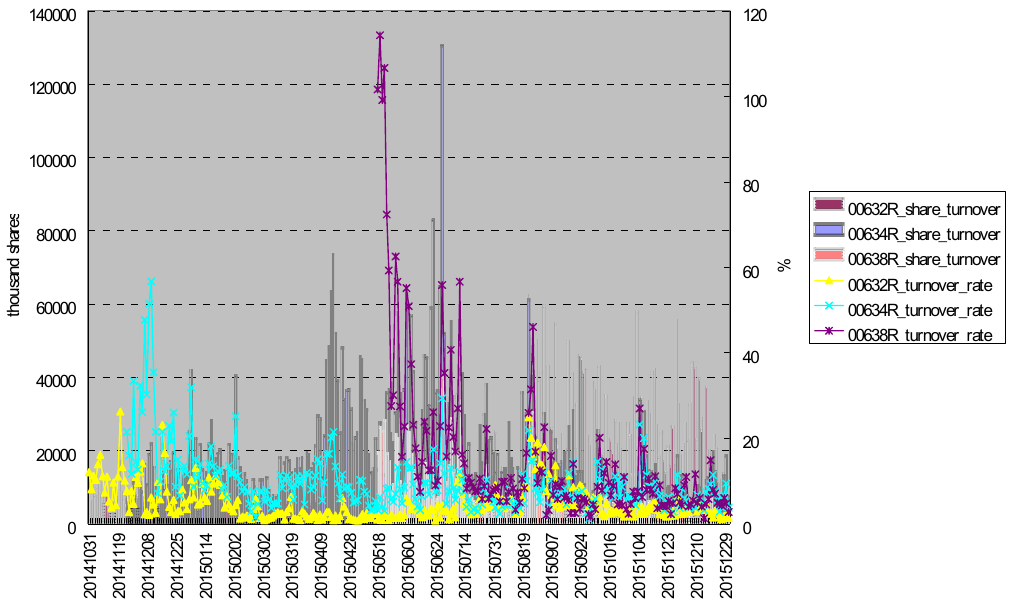
Fig. 1. Daily turnover of the three inverse ETFs, October 31, 2014 to December 31,